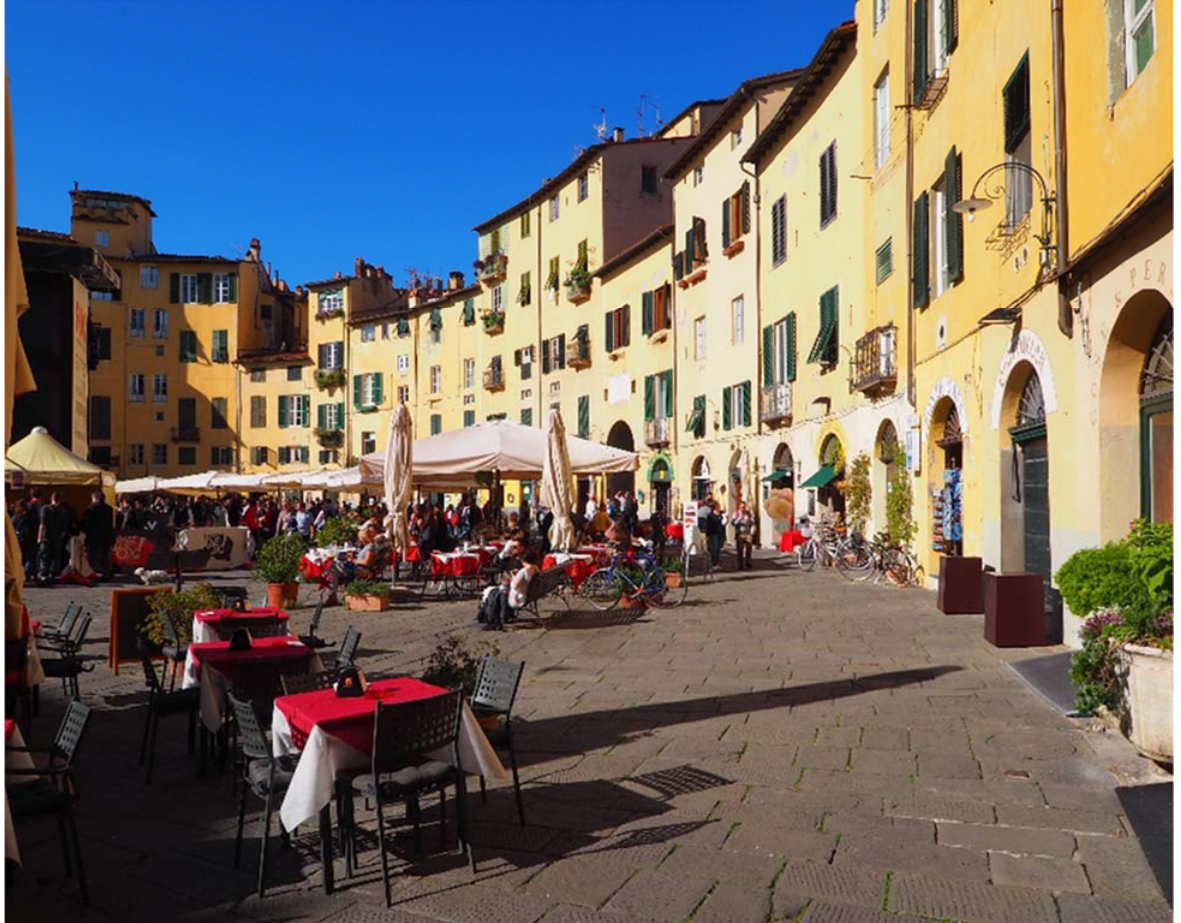
Figure 7. Walking 60 feet from the red ‐ topped table in the foreground to the pavilion tent in the center of the picture, the brain undergoes 90 to 120 scanning cycles. The Piazza dell’Anfiteatro in Lucca, Italy. Photo N. H. Buras.